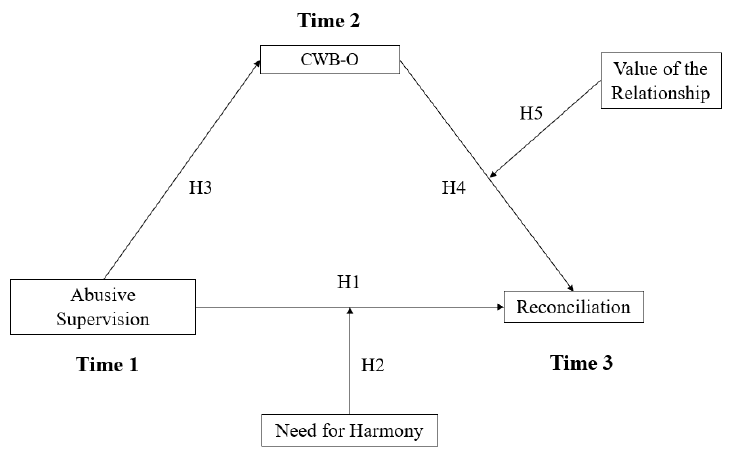
Figure 1. Conceptual Model.